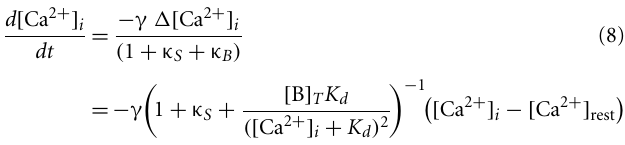
Bottom trace: measured cellular calcium signal (black) as well as simulated (cid:2) F / F traces (red) for the recorded spike train (sampling rate: 7.81Hz; expressed as relative percentage change (cid:2) R / R of the YFP/CFP fluorescence ratio). A non-saturating model with single-exponential decay was used to generate the simulated trace. (C) Noise (cid:2) F / F trace during episode without AP, as confirmed by simultaneous cell-attached recording (data not shown). Sampling rate: 490Hz. (D) Left: distribution of signal intensities for data shown in (C) . Gaussian fit in red ( r 2 = 0 . 98). Right: distribution of goodness-of-fit of Gaussian fits ( r 2 ) for pooled data set (96s total recording time). (E) Mean normalized autocovariance ( ± SD) for pooled noise data set. Peak at 0s lag